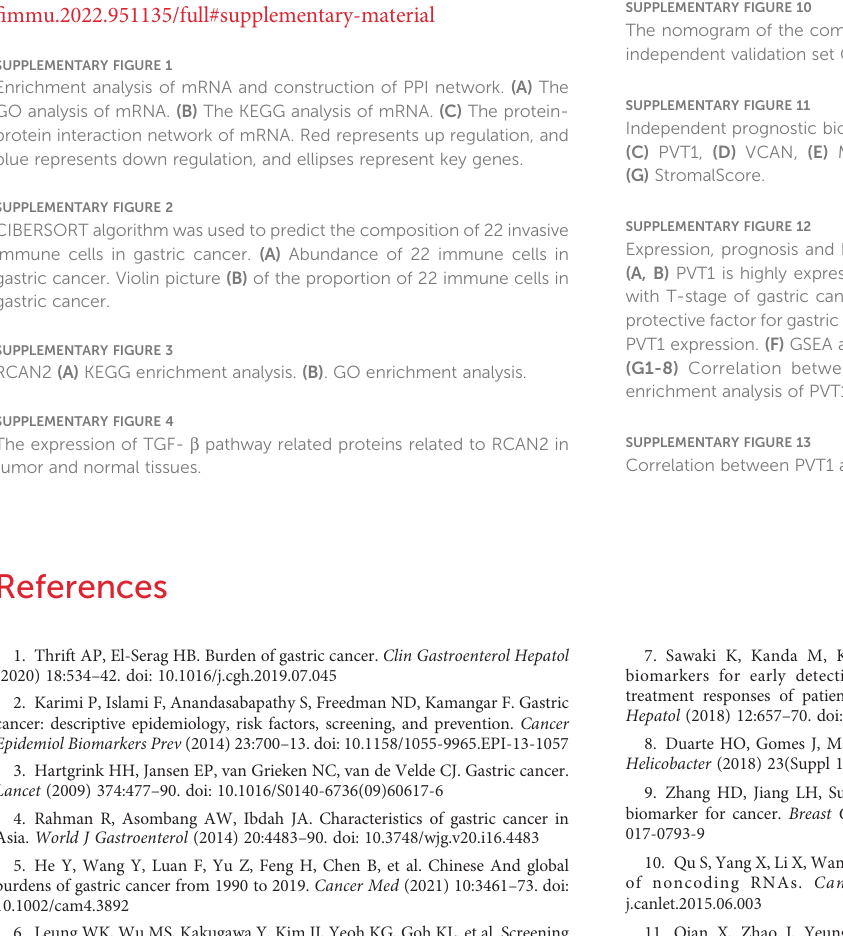
SUPPLEMENTARY FIGURE 8 Thedifferencesintheexpressionofsurvivalstatusandprognosticmarkers of GC patients with different risk scores. (A1-3) Training set based on TCGA database. (B1-3) Veri fi cation set based on GEO62254. (C1-3) Veri fi cation set based on GEO15459.